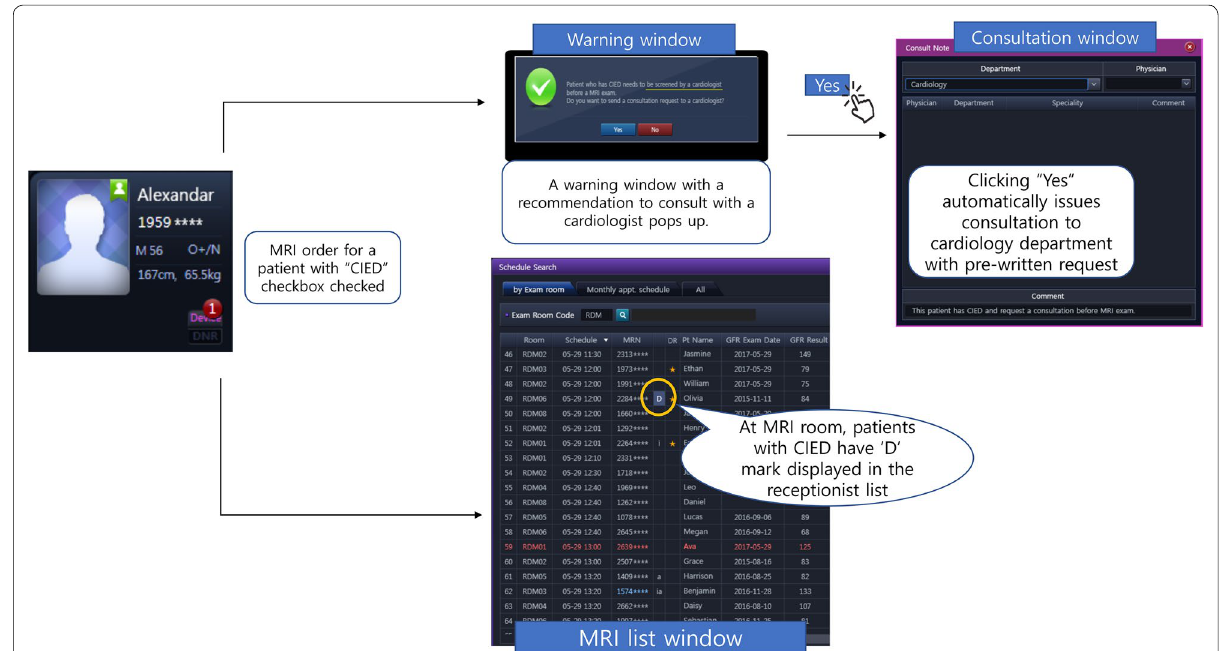
Fig. 2 Process of the automatic consultation system. An MRI order for a patient with an activated “Device” alert automatically opens a warning pop‑up window, which notifies the necessity of pre‑MRI evaluation for the patient and asks whether to make a consultation request to a cardiologist. Clicking “yes” issues a pre‑written consultation request for pre‑MRI cardiologic evaluation. Medical personnel at the MRI facility can also identify this patient by additional “D” mark in the receptionist list. MRI magnetic resonance